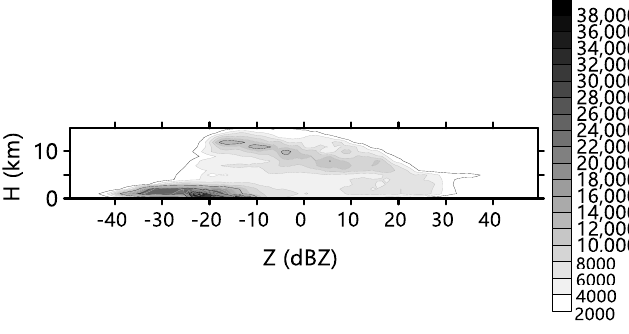
Figure 13. Numbers of occurrences of merged reflectivity.